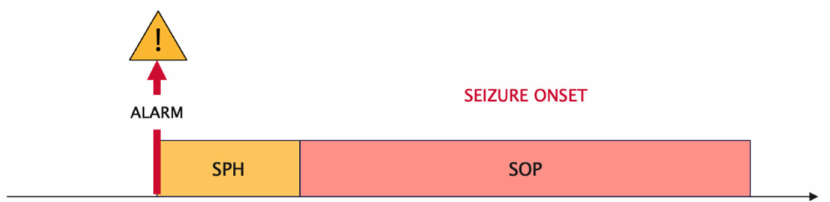
Figure 2. The definition of seizure prediction horizon (SPH) and seizure occurrence period